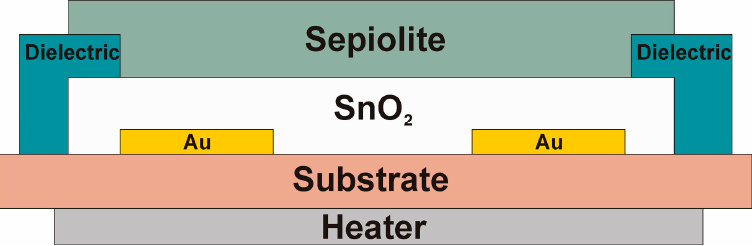
Figure 1. The cross-section of the structure of the thick-layered gas sensor based on tin dioxide (IV) with a sepiolite filter.